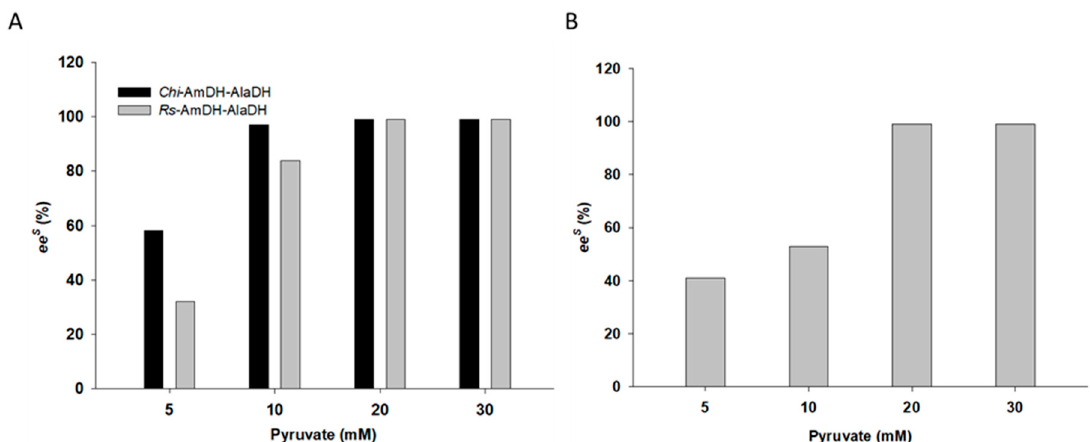
Figure 4. Effect of pyruvate concentration on the kinetic resolution of ( A ) rac- a3 by Chi-AmDH-AlaDH and Rs-AmDH-AlaDH; and ( B ) rac- a7 by Chi-AmDH--AlaDH. Reaction conditions: 10 mM rac- a7 /rac -a3 , 1 mM NAD + , 1 mg/mL AmDH, 1 mg/mL AlaDH, 5-30 mM Pyruvate, 100 mM Glycine buffer (pH 10.0/9.5).